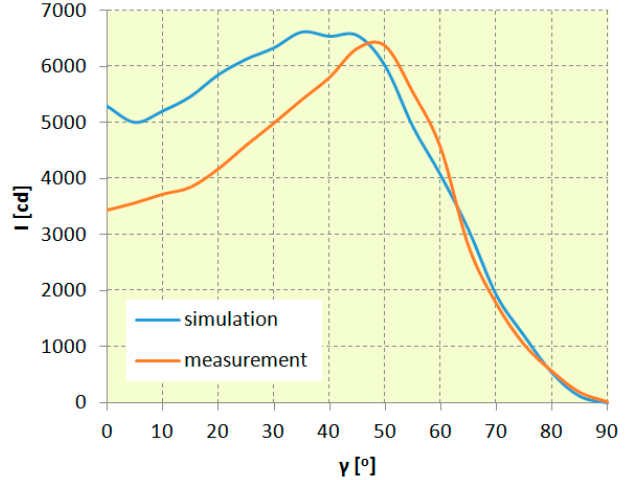
Figure 20. The comparison of luminous intensity curves of a light-optical system for wide distribution obtained as a result of simulation and prototype measurements.